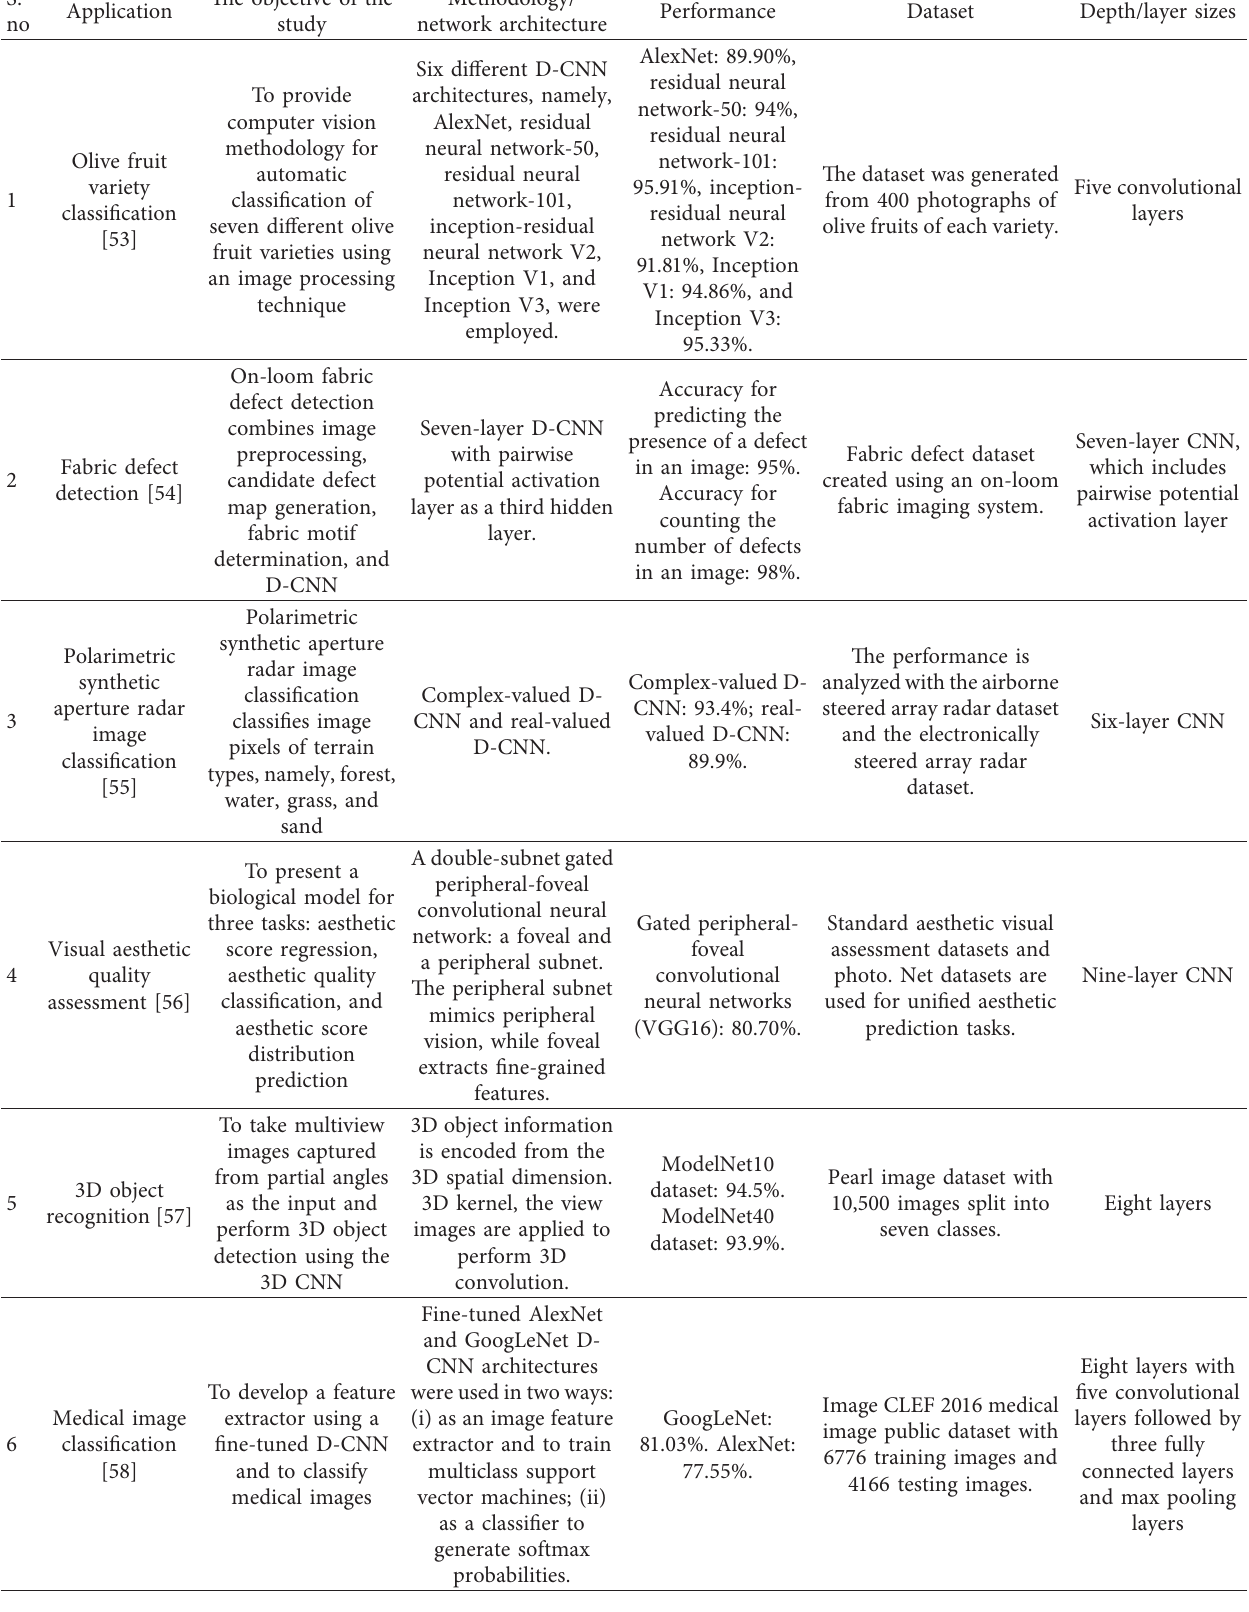
Table 3: Recent advancements of the D-CNN in computer vision.